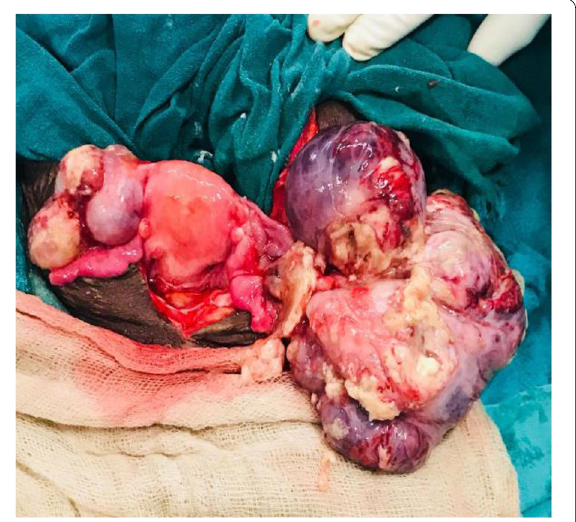
Fig. 4 Bilateral adnexal masses showing growth. Right and left adnexal masses measuring 9